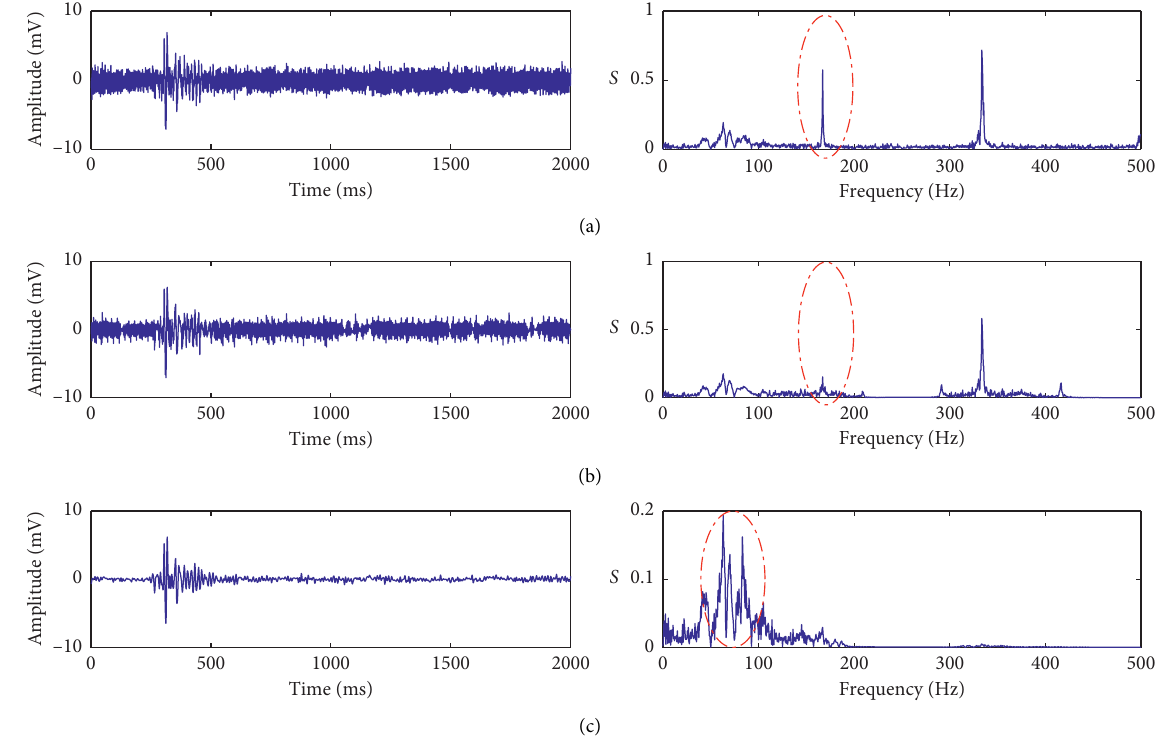
Figure 2: Denoising results in the time-frequency domain: (a) original signal, (b) Rigrsure and (c)